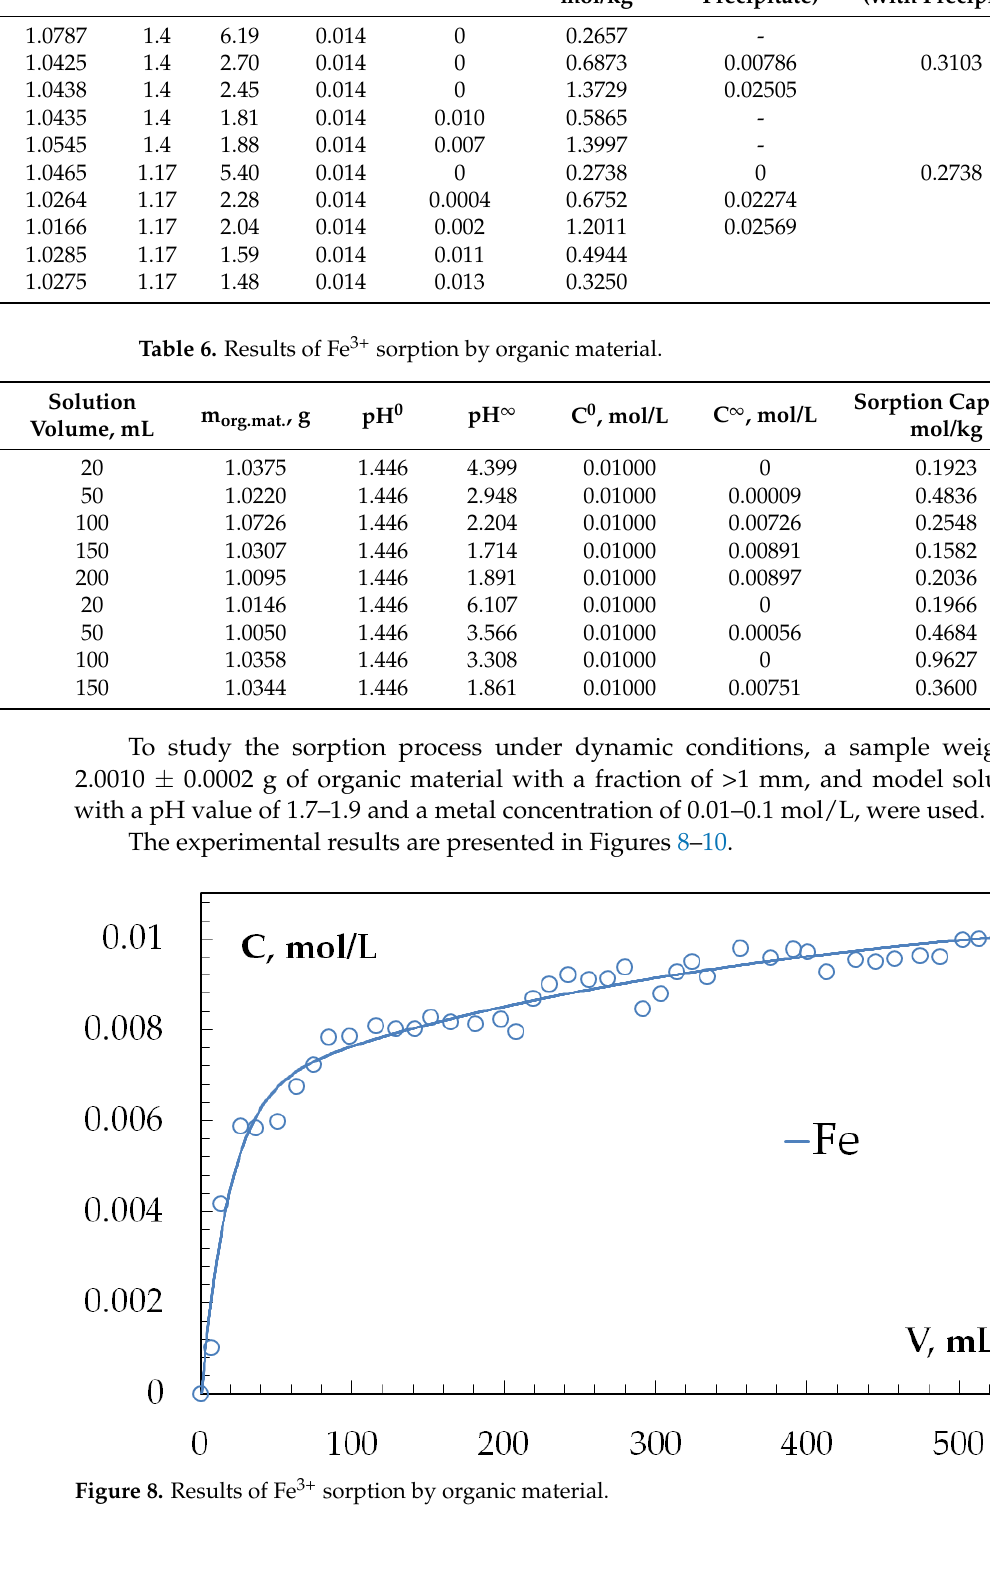
Figure 8. Results of Fe 3+ sorption by organic material.